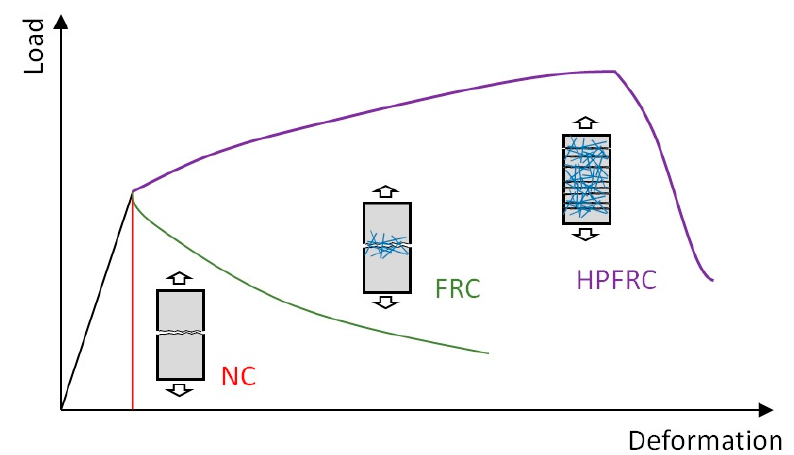
Figure 1. Tensile stress deformation behavior of normal concrete (NC), fiber-reinforced concrete (FRC), and high-performance fiber-reinforced concrete (HPFRC) [11–13]. 55